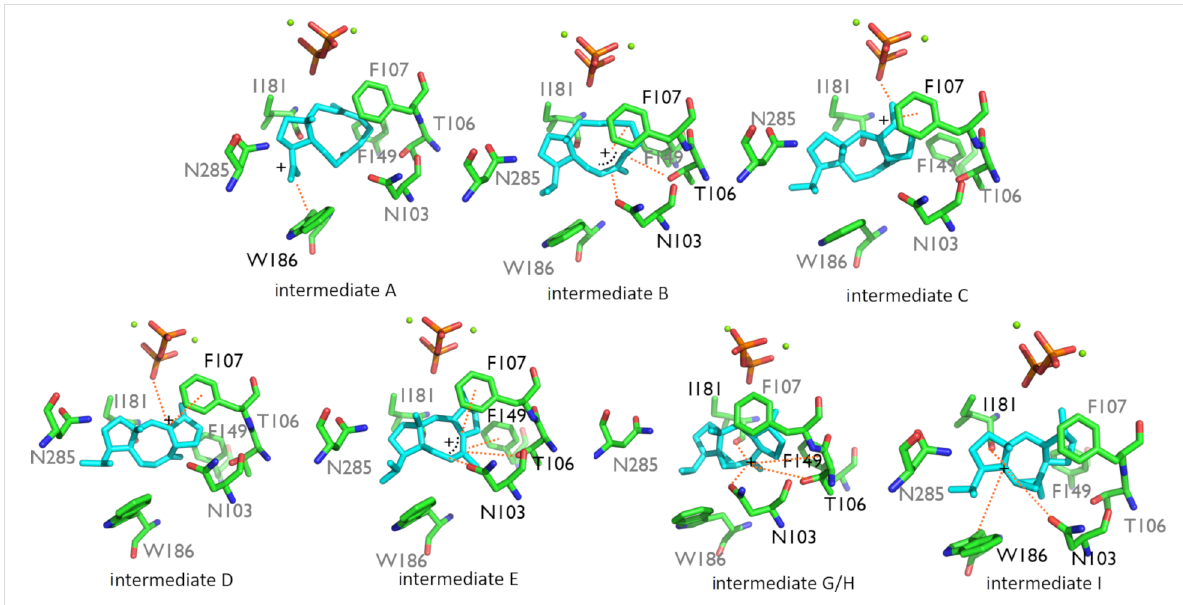
Figure 2: Intermediates A – I in the active site model. Interactions are marked by dashed orange lines, the interacting residues are labeled in black, the non-interacting residues are labeled in grey, and plus signs note location of the